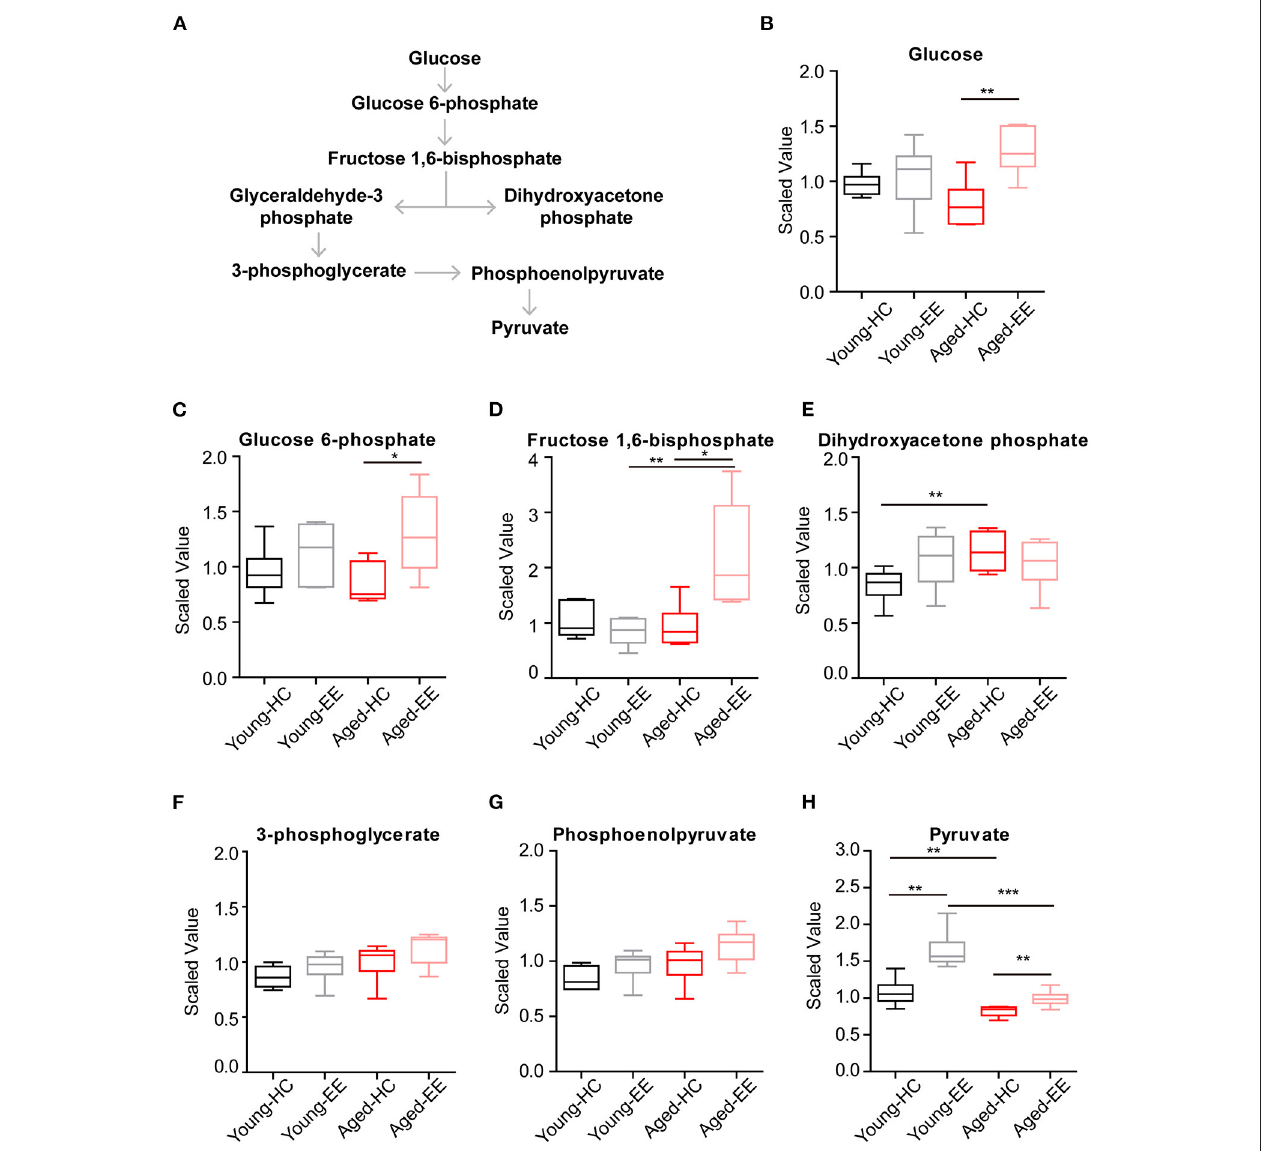
FIGURE 2 | Concentration of metabolites related with glycolysis of aged hippocampus. (A) Schematic drawing of the general glycolytic metabolism pathway. (B–H) Box plots of the levels of glucose (B) , glucose-6-phosphate (C) , fructose 1, 6-bisphosphate (D) , dihydroxyacetone phosphate (DHAP) (E) , 3-phosphoglycerate (F) , phosphoenolpyruvate (G) , and pyruvate (H) in young adult and aged mice under HC and EE condition. HC, n = 6; EE, n = 6; * p < 0.05, ** p < 0.01, *** p < 0.001; unpaired t